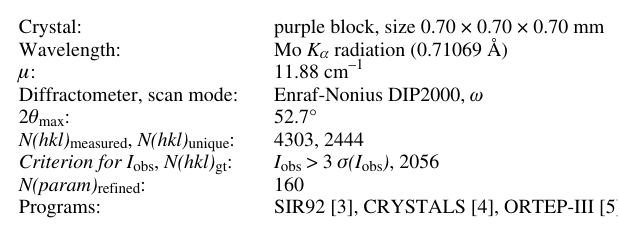
Table 1. Data collection and handling.